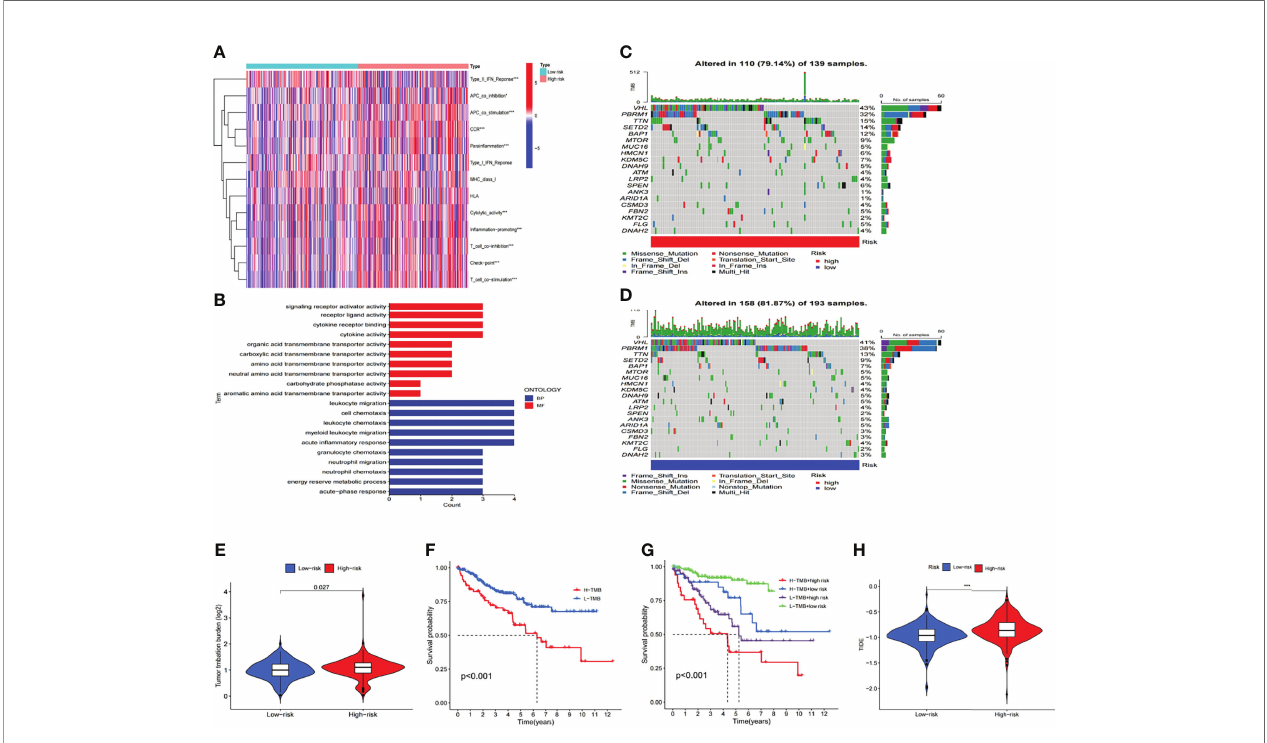
FIGURE 8 | Estimation of the tumor immune microenvironment and cancer immunotherapy response with the m6A-related LncRNA model in the entire TCGA set (A) The indicated standards of the immunity index for each patient. (B) GO enrichment analysis. (C, D) The mutation information of the genes with high mutation frequencies in (C) the high-risk group and (D) the low-risk group presented by Waterfall plot. (E) TMB difference in patients of both groups. (F, G) Kaplan-Meier curve analysis of OS of patients classi fi ed according to the high/low mutation status and m6A-related lncRNA model. (H) TIDE prediction difference in patients of both groups.